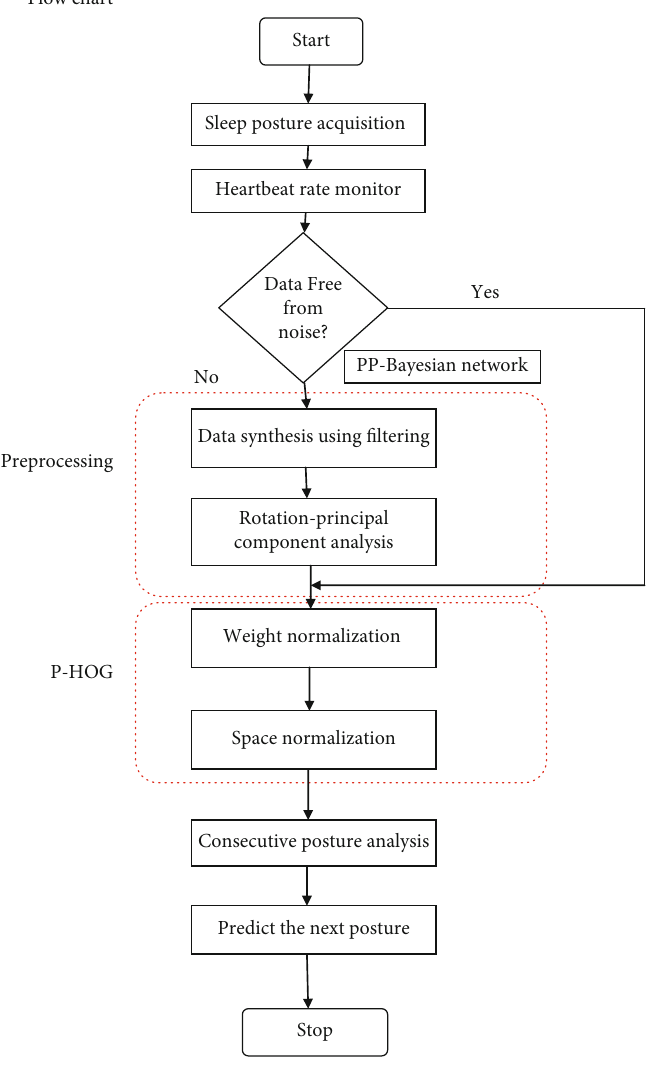
Figure 3: PP-BN process fl ow.